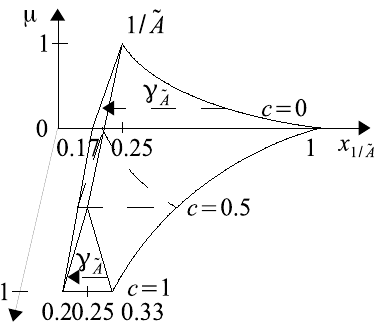
Figure 24. Inverse T2FN 1/ ˜ A in 3D space, determined by the Formula (44).